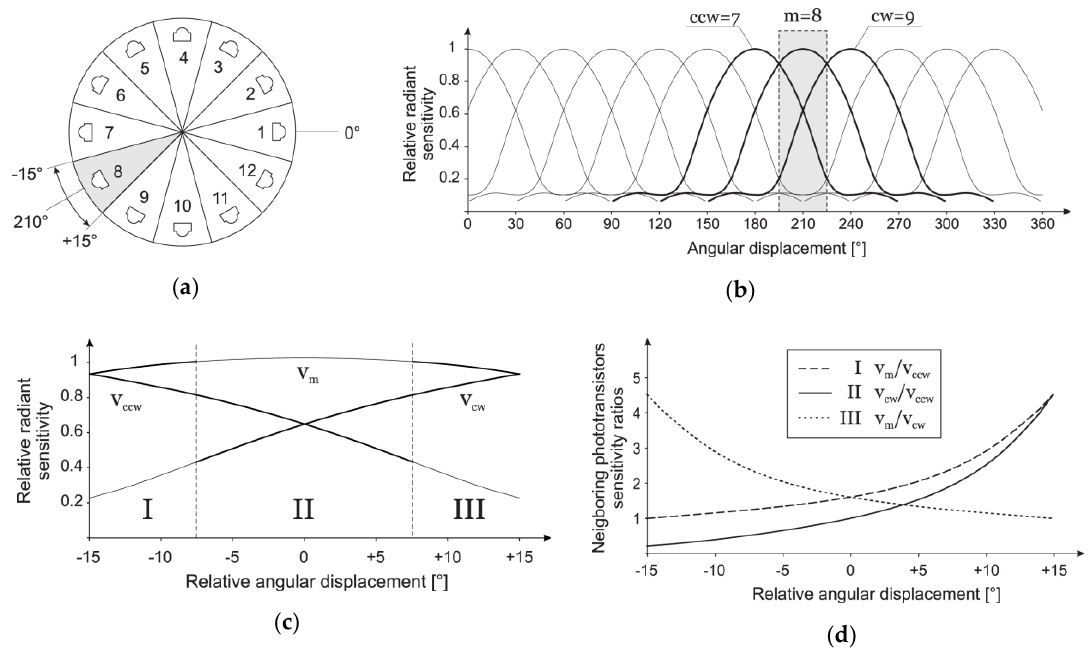
Figure 4. ( a ) AoA sensor layout; ( b – d ) diagrams used in the estimation algorithm, obtained from nominal phototransistor sensitivity as defined in the datasheet.